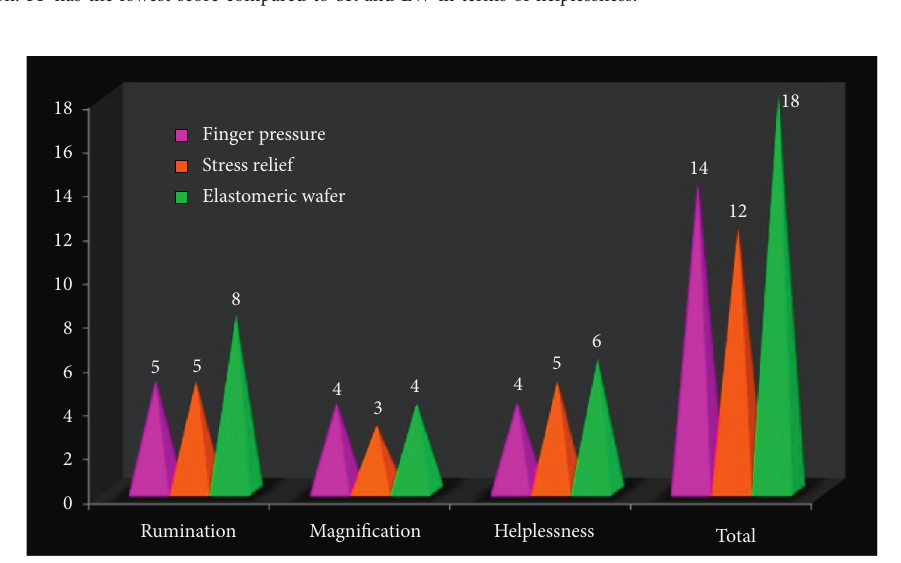
Figure 3: Median score for PCS. Table 3: Descriptive statistics for VAS scores.